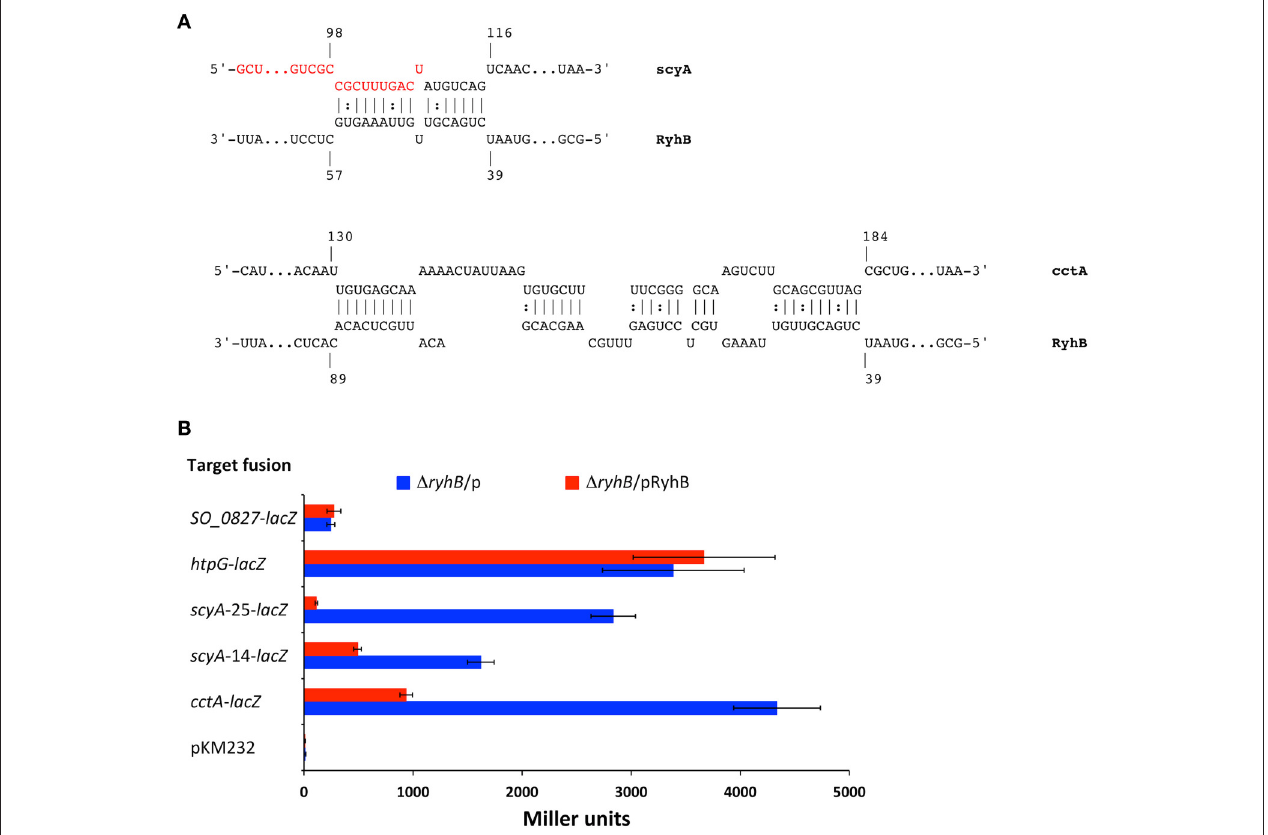
FIGURE 4 | RyhB regulation of ScyA and CctA expression is mediated by sequences in the start of the genes. (A) Predicted interactions between RyhB and scyA and cctA mRNAs. Predictions were made with IntaRNA ( Busch et al., 2008; Wright et al., 2014; Mann et al., 2017). Nucleotides are numbered according to their transcription start site (Shao et al., 2014). The transcription start site is located 66 nt upstream from the translational start for scyA . cctA contains two transcription start sites located 85 and 131 nt upstream from the translational start site, respectively (the numbers in the figure refer to the start site 131 nt upstream the translational start, which is used for the cctA-lacZ fusion). Nucleotides marked in red are designating the end of scyA codons in the fusion scyA- 14 -lacZ . (B) Regulation of target gene fusions by expression of RyhB. β -galatosidase activity was quantified from gene- lacZ fusions harbored on a plasmid in the presence of another plasmid with inducible RyhB production, pKM033-ryhB (pRyhB), or in the presence of an empty plasmid, pKM033 (p). pKM232 contains a promoter-less and truncated lacZ gene missing the first 8 codons. Data are from two independent experiments, each with duplicate cultures, and triplicate samples. Activity is expressed as the mean (Miller units) ± SD